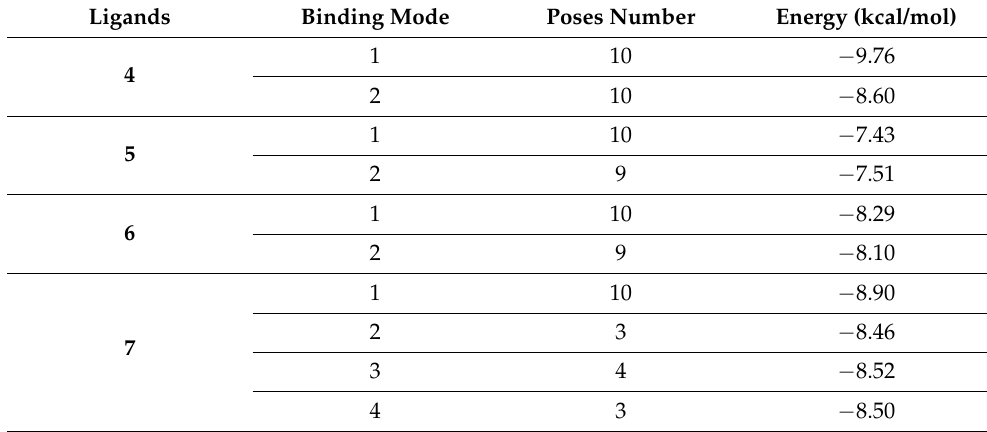
Table 1. Binding energy and population of 4 , 5 , 6, and 7 into EP4 using AutoDock Vina [38].